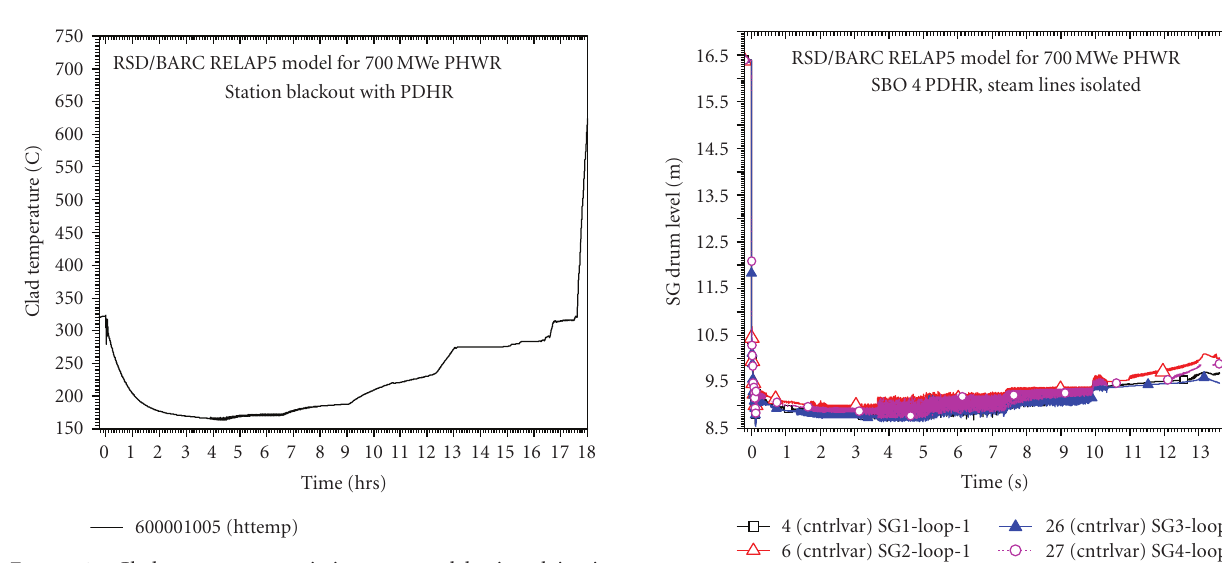
Figure 17: SG level case-steam line